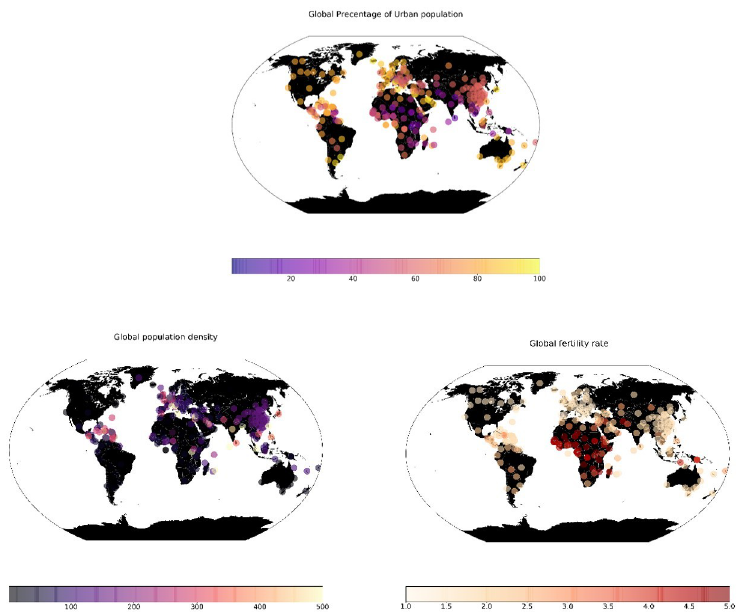
Fig 4. The selected three factors (urban population, population density, and fertility